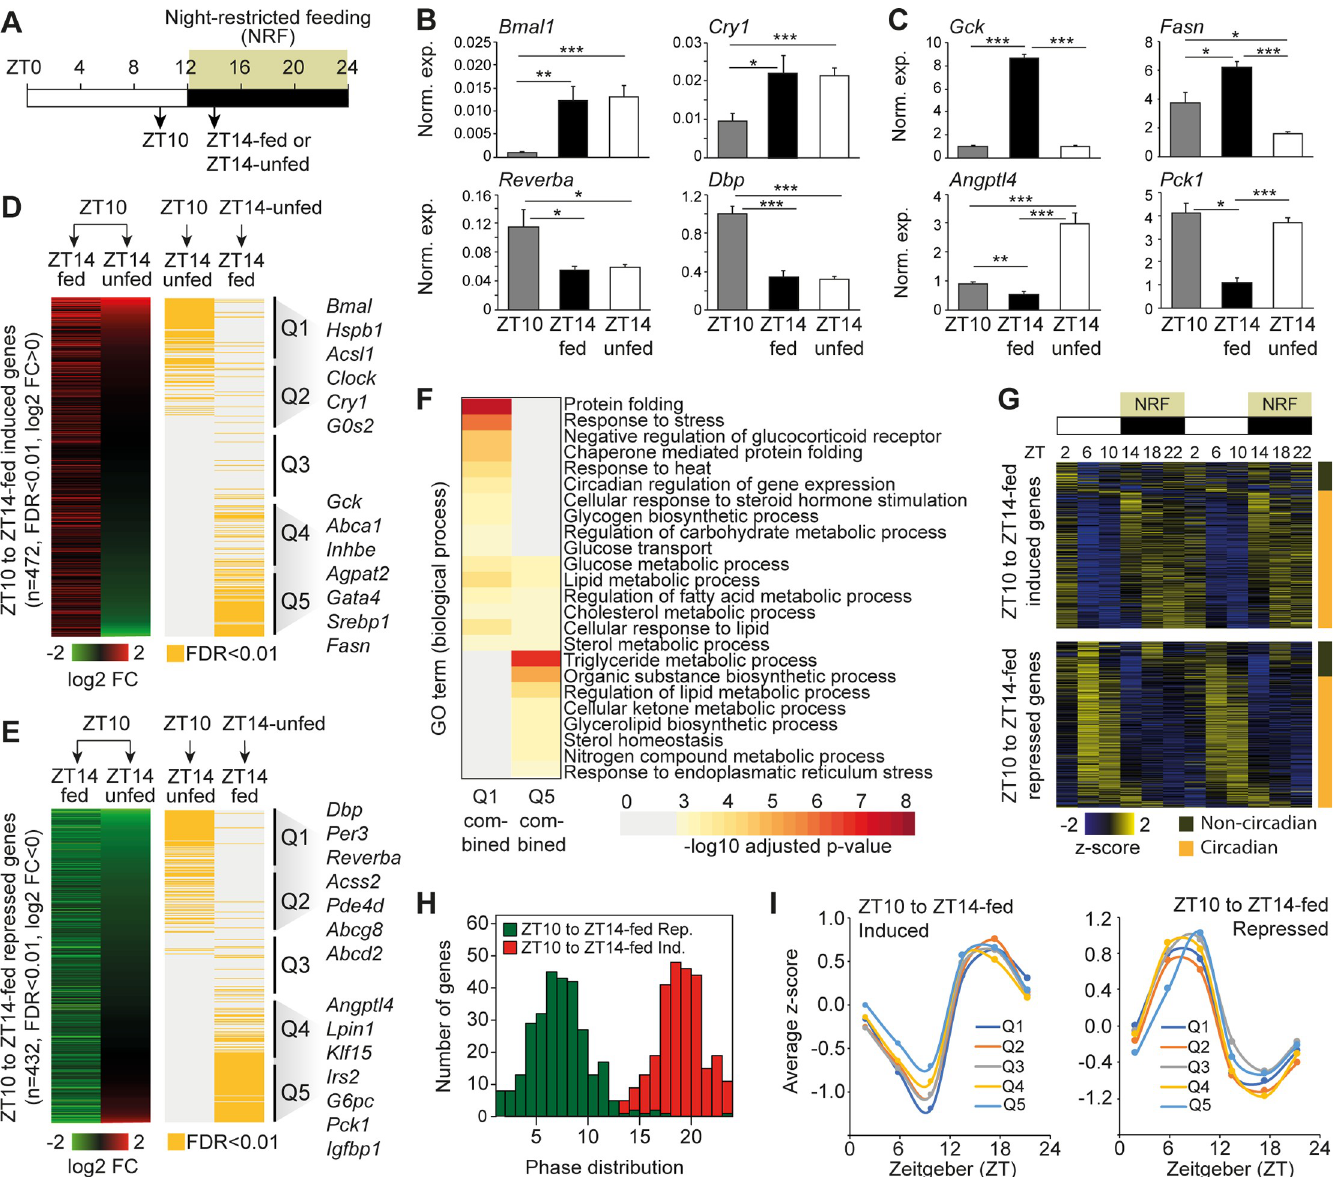
Fig 1. Diurnal hepatic gene expression controlled by feeding. (A) Experimental setup. Mice were housed at constant 12-h light/dark cycles and subjected to NRF. Livers were isolated at ZT10 and ZT14 (ZT14-fed). In parallel, livers from a cohort of mice, kept unfed from ZT12 to ZT14, were isolated at ZT14 (ZT14-unfed). (B) RT- qPCR analysis of genes controlling the core circadian clock and (C) genes regulated by feeding. Data is presented as mean ± SEM ( n = 5). Statistical significance is evaluated by Student t test. (D) Genes induced in the livers from mice at ZT10 compared to ZT14-fed and (E) genes repressed in the livers from mice at ZT10 compared to ZT14-fed. Data is presented as mean log2 FC, FDR < 0.01, n = 2. Genes regulated by feeding (ZT14-unfed relative to ZT14-fed) and genes regulated by the transition from ZT10 to ZT14-unfed with FDR < 0.01 are indicated by the orange color scale. Based on the log2 FC (ZT10 relative to ZT14-unfed), genes are grouped into five bins of equal size (Q1–Q5), in which Q1 represents genes primarily unaffected by feeding and Q5 genes primarily affected by feeding. (F) Enriched GO terms for genes in group Q1 and Q5. (G) Circadian expression of genes differentially expressed from ZT10 to ZT14-fed. RPKM values and calculation of phases are from Atger and colleagues [1]. RPKMs are visualized as z-scores. Genes with a phase > 1 are indicated with orange. (H) Phase distribution of differentially regulated genes (ZT10 to ZT14-fed). (I) Average z-scores at different time points during a circadian rhythm for genes grouped in Q1–Q5. � p < 0.05, �� p < 0.01, ��� p < 0.005. Numerical values for panels B–I are available in S1 Data. FC, fold change; FDR, false discovery rate; GO, gene ontology; NRF, night-restricted feeding; RPKM, reads per kilo base per million mapped reads; RT-qPCR, reverse transcription quantitative PCR; ZT, Zeitgeber time.